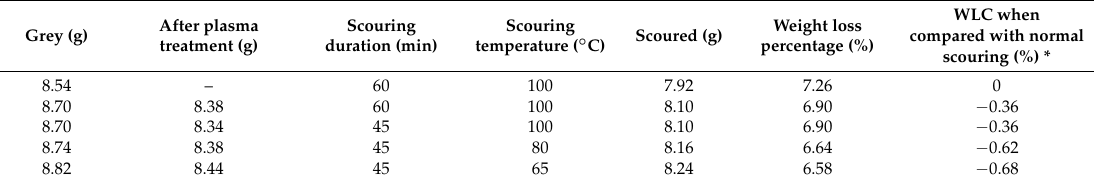
Weight loss difference (WLC) between plasma-treated and scoured interlock fabric (plasma condition: 150 W output power and 0.4 L/min flow